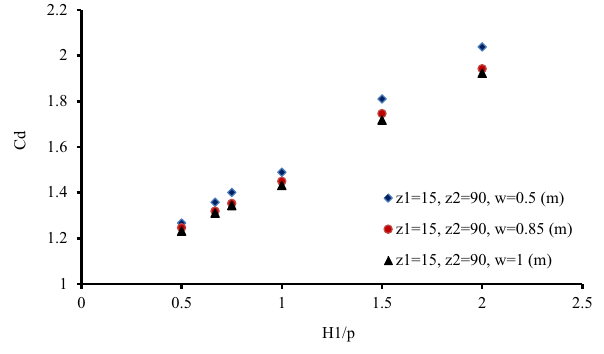
z 1 = 15°, 2 = 90° and various crest